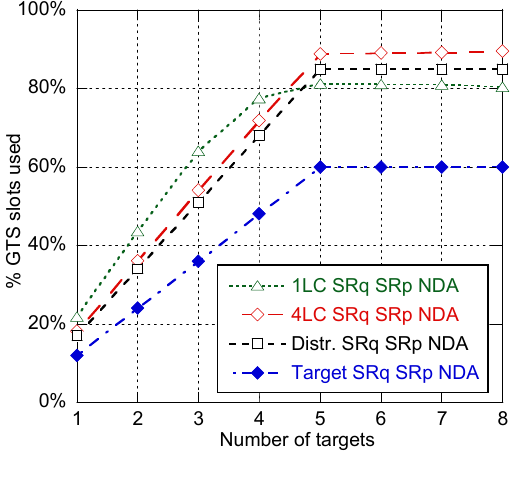
Figure 13. % of GTS slots used for location data transmission for the different architectures (SRq SRp